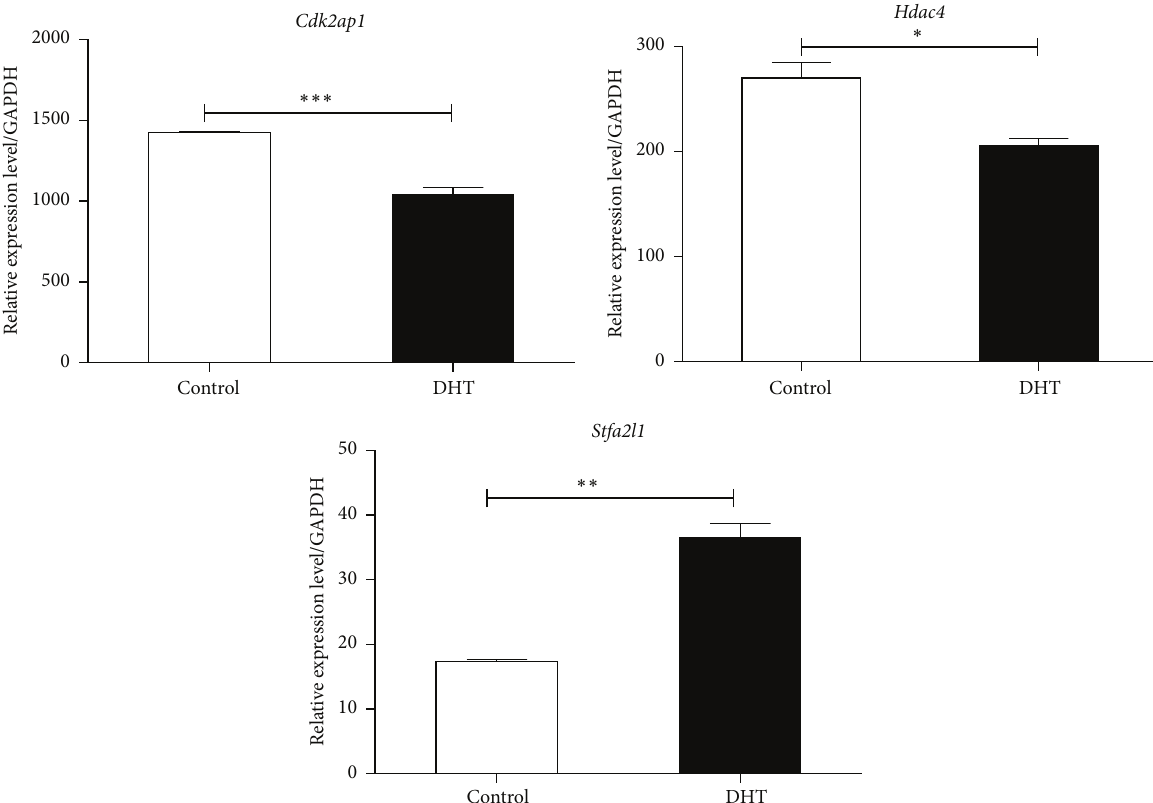
Figure 7: Validation of gene expressions by qPCR. Genes were selected based on the fold change of expression differences or the association with the biological functions of EPCs and angiogenesis. Sixteen genes from the microarray result were validated by qPCR, and 11 of them were consistent with the results of microarray data. All assays were triplicated and demonstrated similar results. Data are presented in mean ± SD format. ∗ 𝑃 < 0.05 versus control group, ∗∗ 𝑃 < 0.01 versus control group, and ∗∗∗ 𝑃 < 0.001 versus control